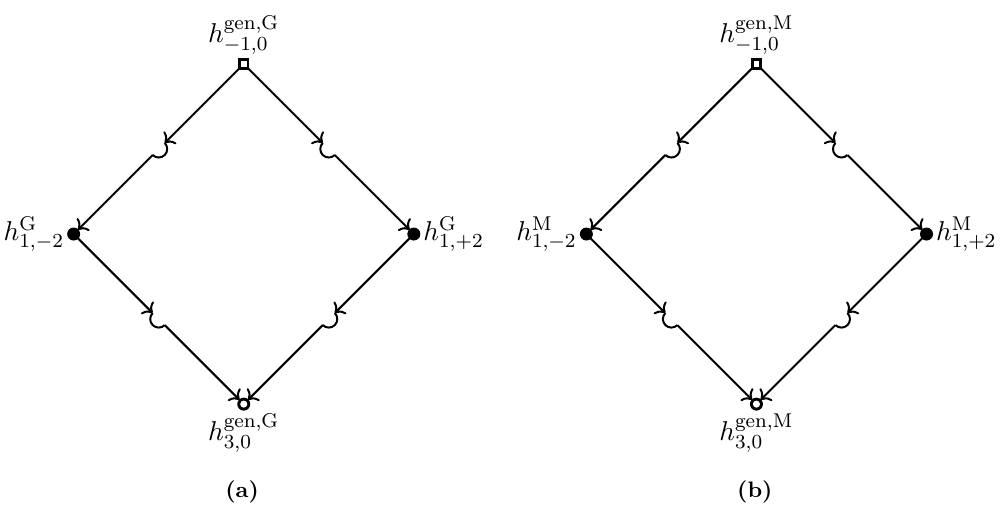
Figure 7. Goldstone (a) and memory (b) diamonds for the leading soft graviton theorem. Bottom